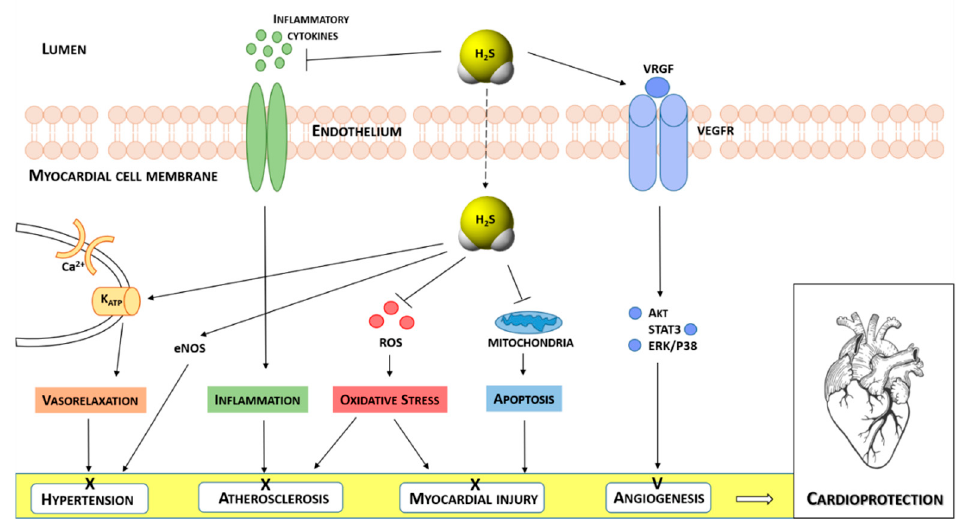
Figure 1. Schematic illustration of the effects of H 2 S in different heart diseases and the molecular mechanisms underlying H 2 S-induced cardioprotection.